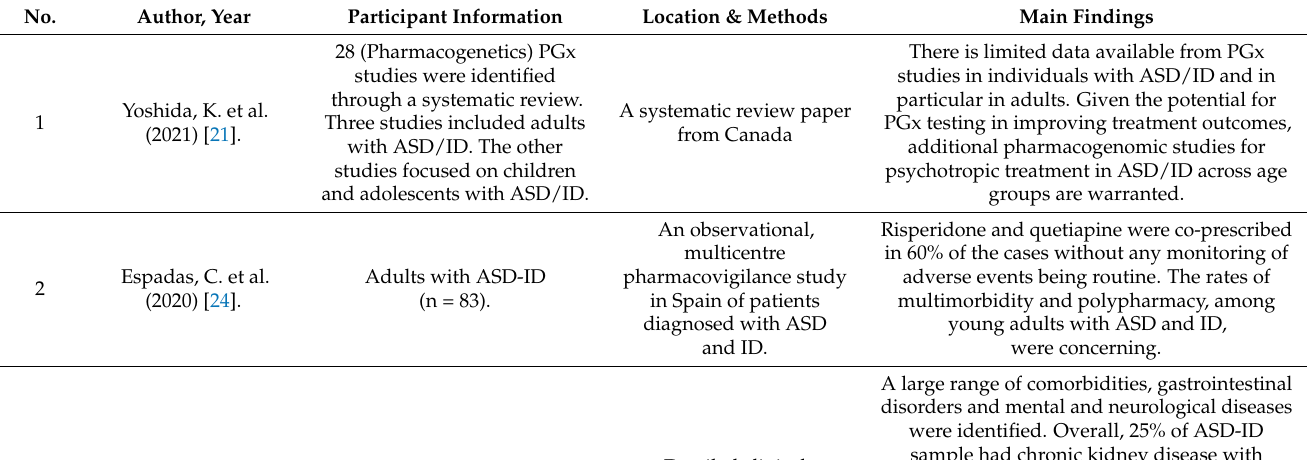
Table 2. Summary of findings from identified papers